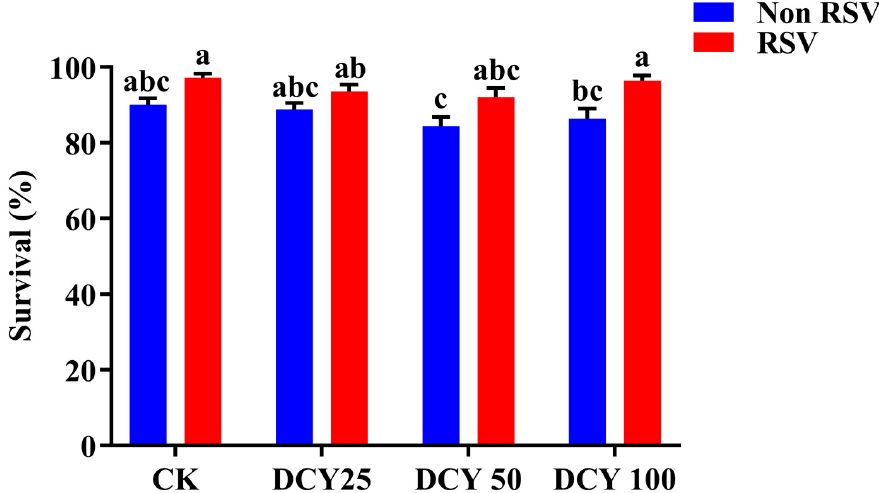
Figure 3. Nymphal survival of different populations of SBPH on DCY-treated rice. Significant differences between treatments are indicated by different letters ( p < 0.05, Tukey’s HSD test).